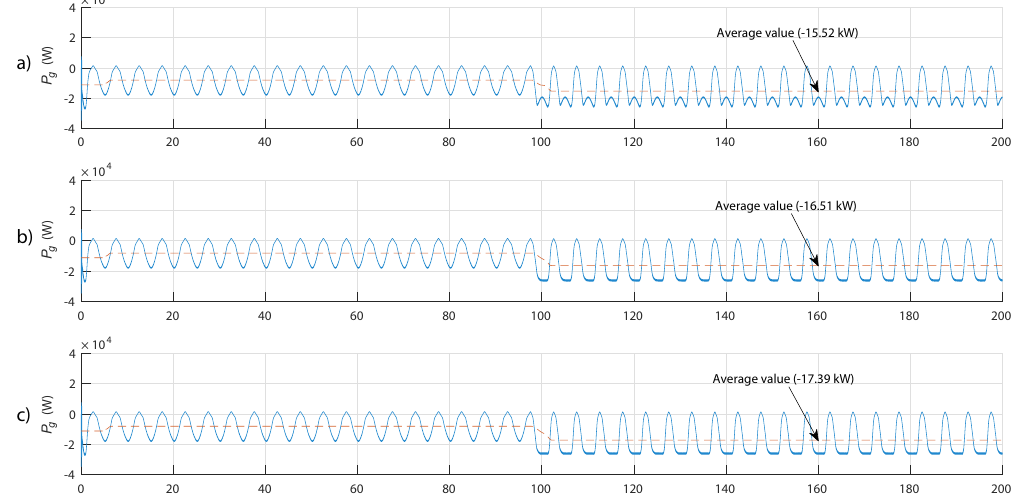
Figure 24. Generated power for the OWC. ( a ) Uncontrolled case. ( b ) ANN1-rotational speed control. ( c ) ANN2-rotational speed